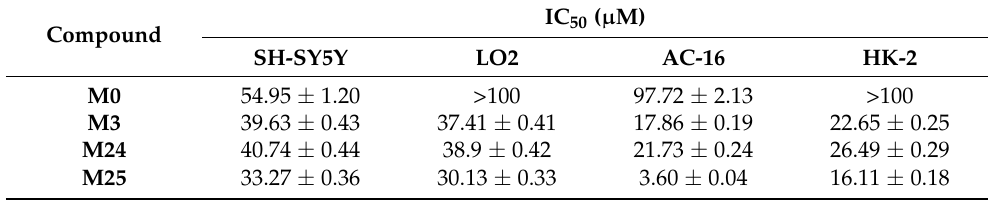
Table 5. The cytotoxicities of euphorbiasteroid and its metabolites on four strains of human cells.